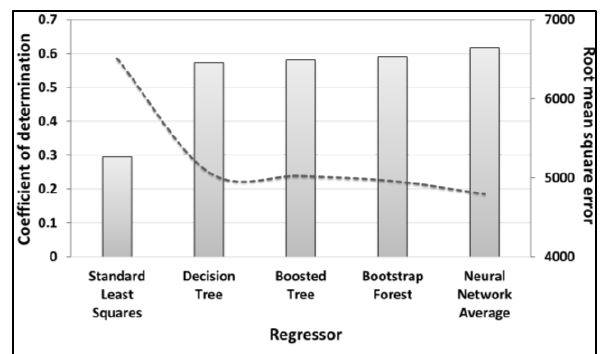
Figure 3 . Barplot of the regression models’ test results for linear standard least squares, non-linear decision tree, boosted tree, bootstrap forest, and the average of neural networks.